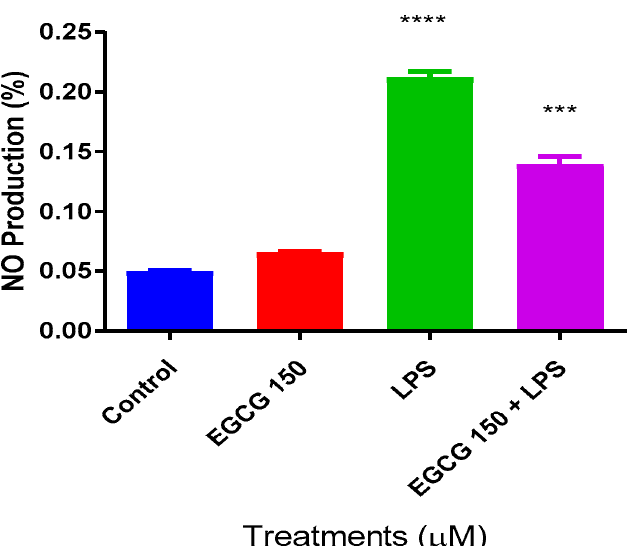
Figure 2. EGCG caused a concentration-dependent decrease in nitric oxide (NO) production. Griess reagent assay was used to measure nitric oxide (NO) production. The X -axis represents the different treatment conditions for BV-2 cells, while the Y -axis shows NO production (%). EGCG 150 µ M showed no significant change when compared to the control. EGCG 150 µ M paired with 1 µ g/mL